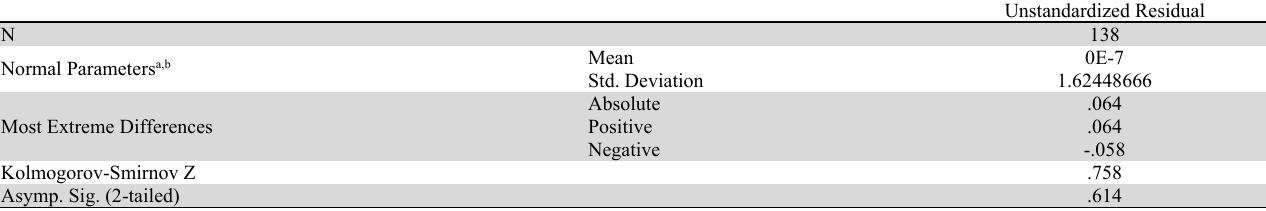
Unstandardized Residual Mean 0E-7 Std. Deviation